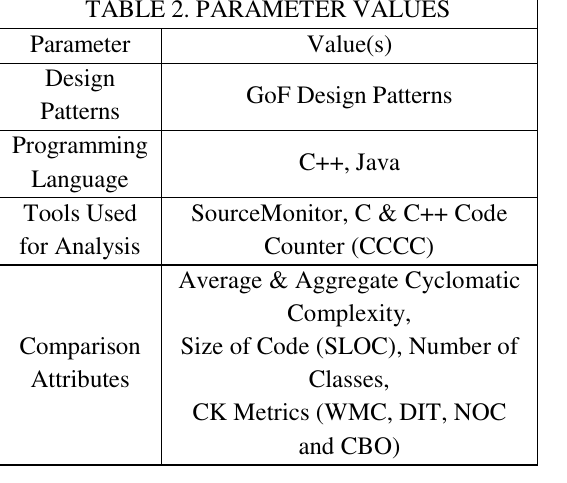
TABLE 2. PARAMETER VALUES